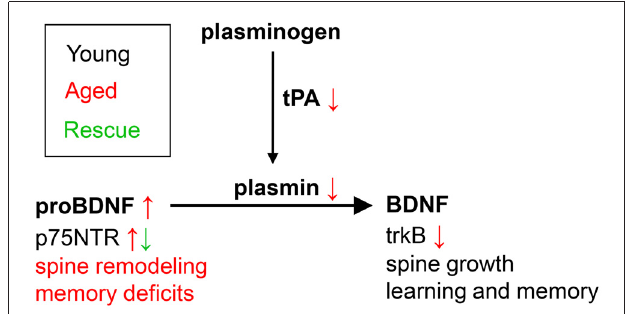
FIGURE 5 | Theoretical model of the role of proBDNF in learning in memory in aged individuals. In young individuals, maturation of proBDNF to BDNF is controlled by plasmin and tPA, and is essential for learning and memory. Aged individuals show decreased levels of tPA and plasmin, and increased levels of uncleaved proBDNF, associated with increased spine remodeling and memory deficits. Blockade of p75NTR (e.g., by TAT-Pep5, as in the current study) leads to spine growth, and rescues learning and